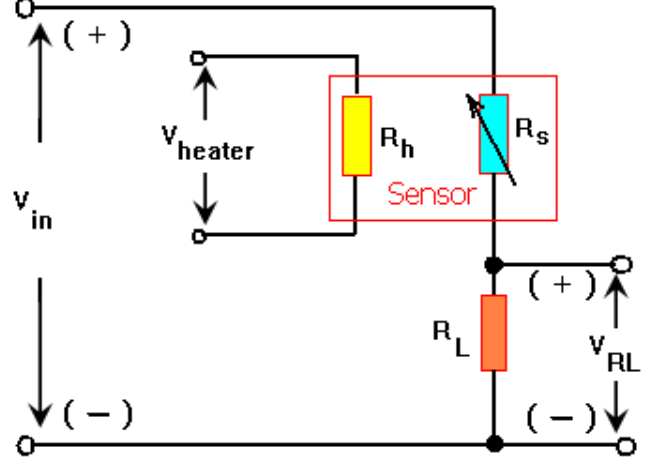
Figure 9. Setup experiment for measuring sensor